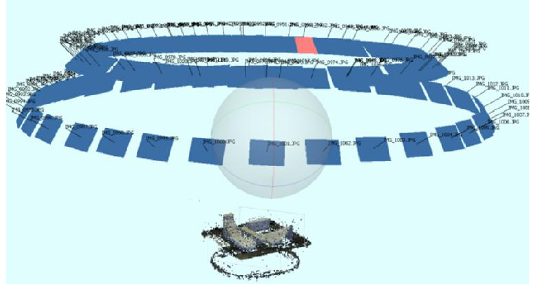
Figure 4. Team 2. Structure from motion on the Metric Test Object (Image and processing courtesy of Agora3D).